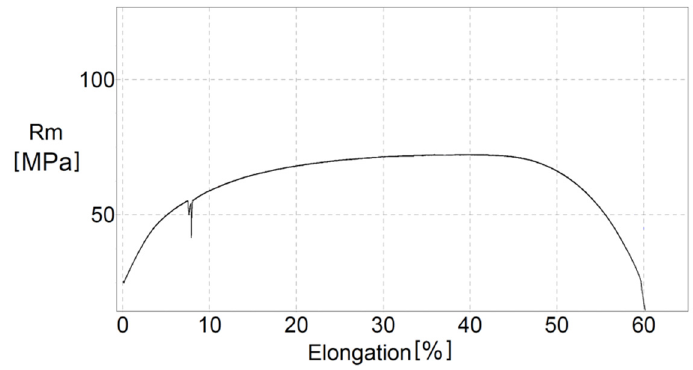
Figure 1. Tensile test of tested material, the stress—strain curve.